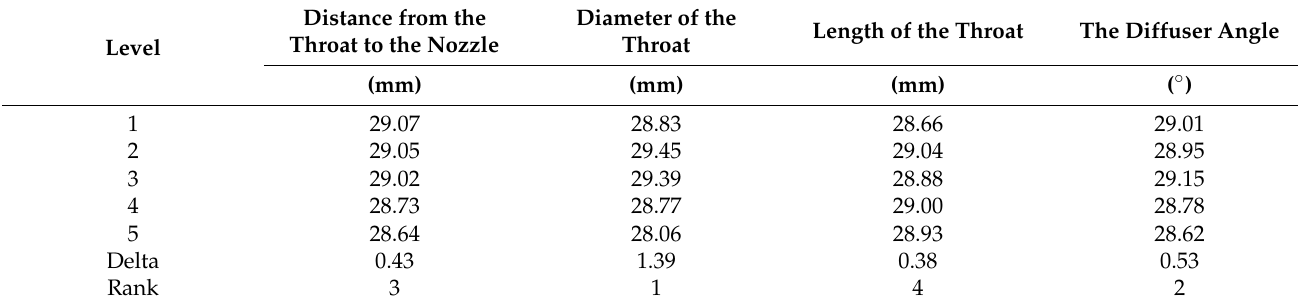
Table 12. The mean response table.